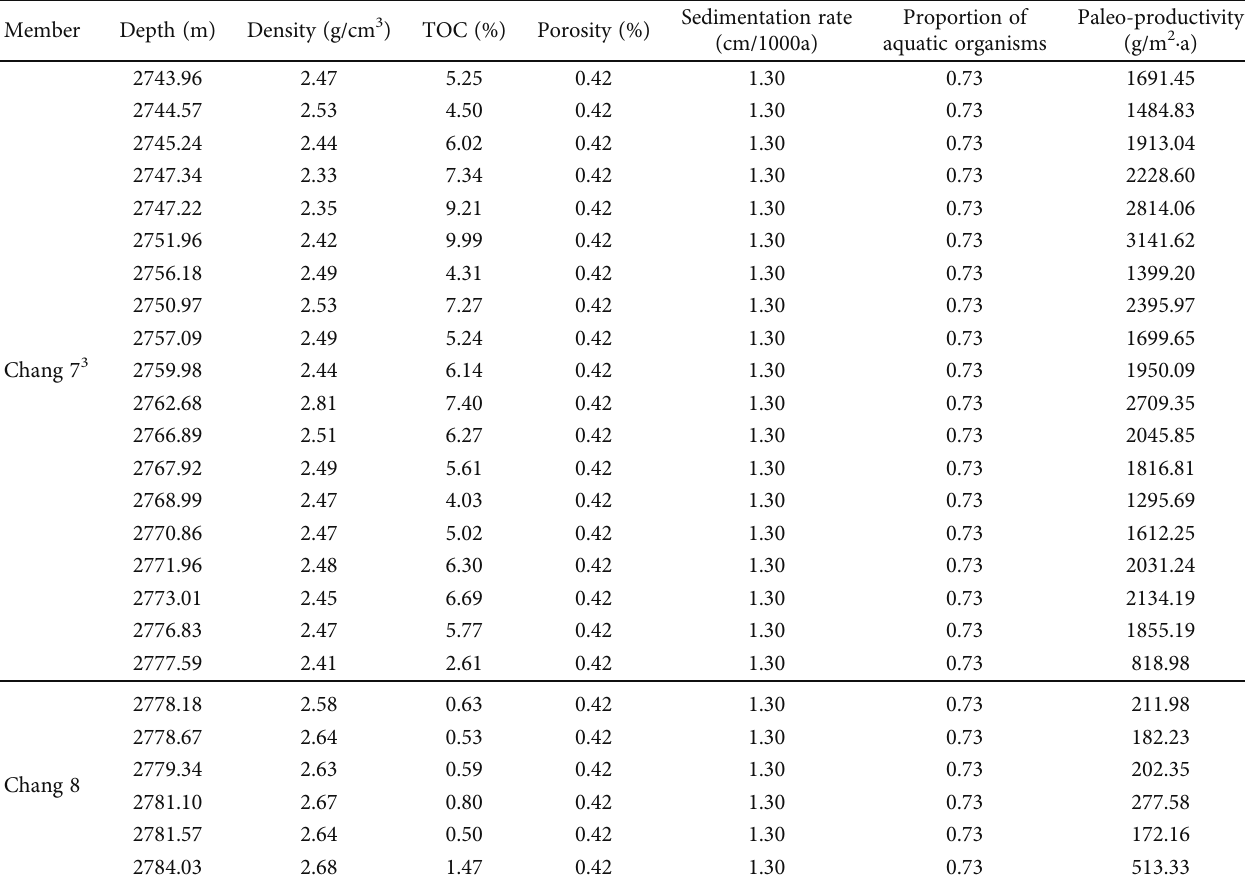
Table 6: Quantitative calculation of the paleo-productivity of Chang 7 3 and Chang 8 intervals from well DP1 in the western Ordos Basin. The parameters of porosity and proportion of aquatic organisms derived from Wang [16] and the sedimentation rate refers to Chen et al.